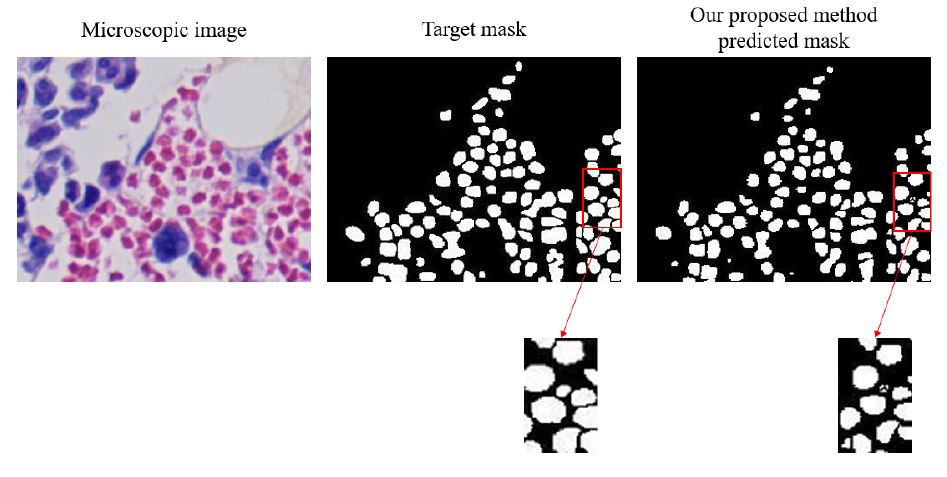
Figure 6. Examples of poor